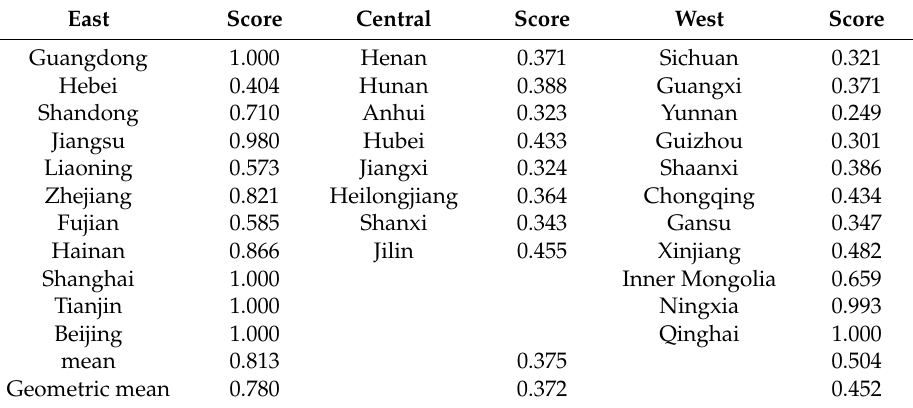
Table 5. Water use efficiency in three regions of China (2008–2016).